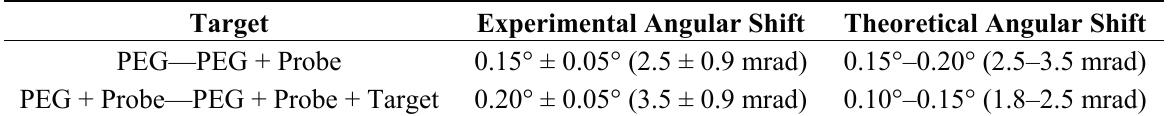
Table 1. SPR measurements: angular shifts of adjacent